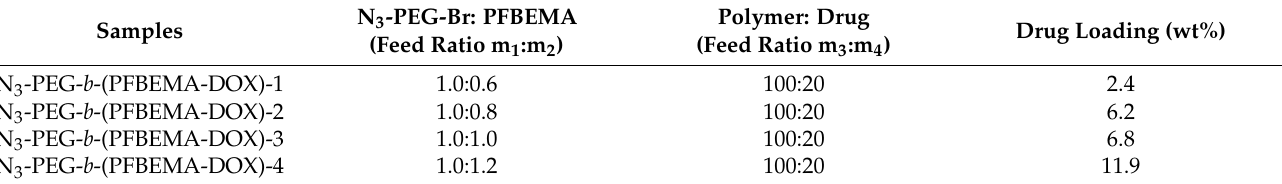
Figure 2. Characterization of polymer prodrug. ( a ) MALDI-TOF MS spectrum of N 3 -PEG-Br, ( b ) UV-vis spectra of N 3 -PEG- b -PFBEMA, free DOX, and N 3 -PEG- b -(PFBEMA-DOX), ( c ) FT-IR spectra of N 3 -PEG- b -PFBEMA, free DOX, and N 3 -PEG- b -(PFBEMA-DOX), and ( d ) MALDI-TOF MS spectra of mAb-CD163 and mAb-CD163-DBCO. Table 1. Feeding formula and drug loading of different samples.